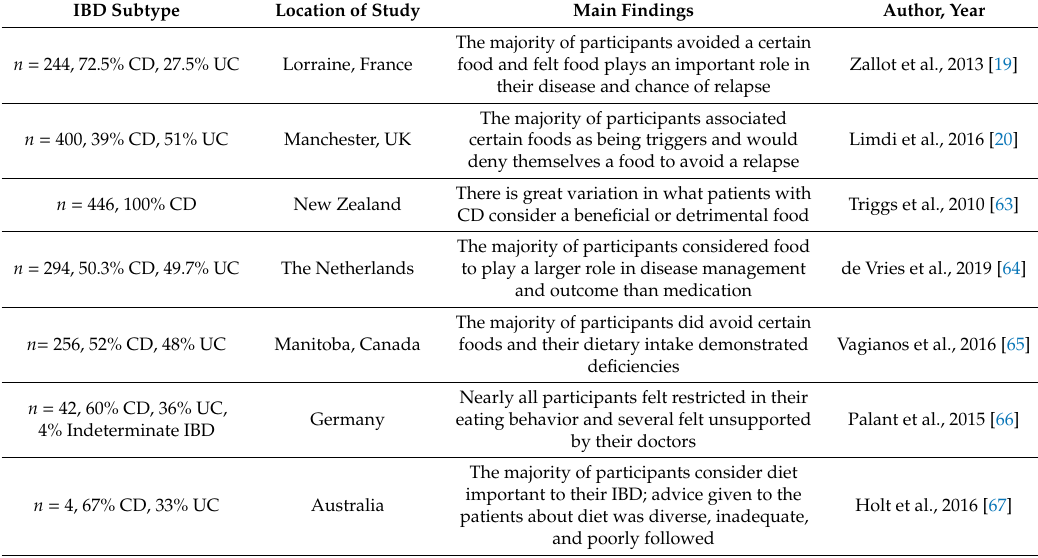
Table 1. Summary of the literature regarding dietary habits of IBD patients. IBD—inflammatory bowel disease, CD—Crohn’s disease, UC—ulcerative